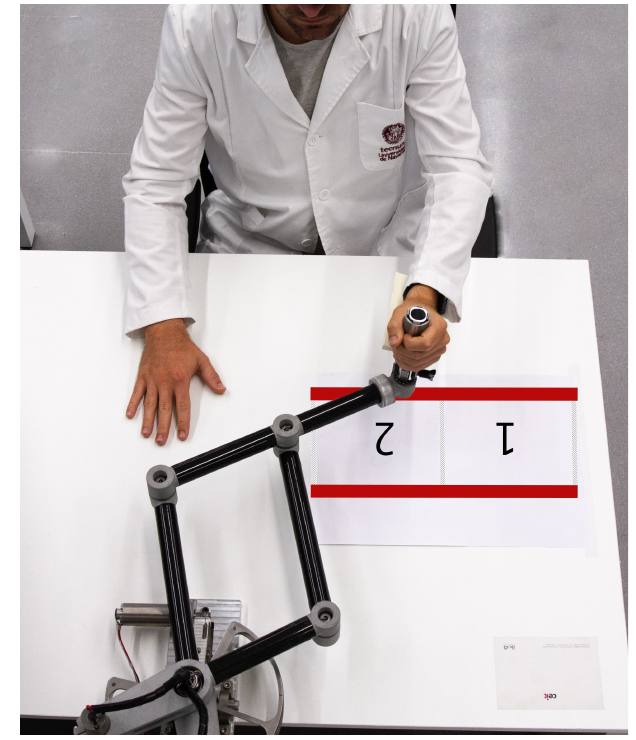
Figure 8. Experimental setup. Table 2. Values applied in the